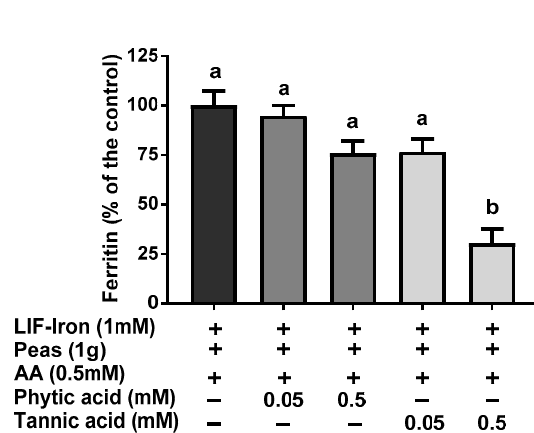
Figure 5. Iron uptake in Caco-2 cells exposed to simulated gastrointestinal digestates of peas and different dietary factors combined with the (Lucky Iron Fish™ (LIF))-iron. Cellular ferritin response exposed for 24 hour incubation with the in vitro gastrointestinal digestion containing LIF-iron plus ascorbic acid (0.5 mM) ( a ) with or without 1g of pea; and ( b ) with pea plus added tannic acid or phytic acid at the indicated concentrations. Data represent means ± SEM ( n = 6–8). Means without a common letter differs ( p < 0.05).